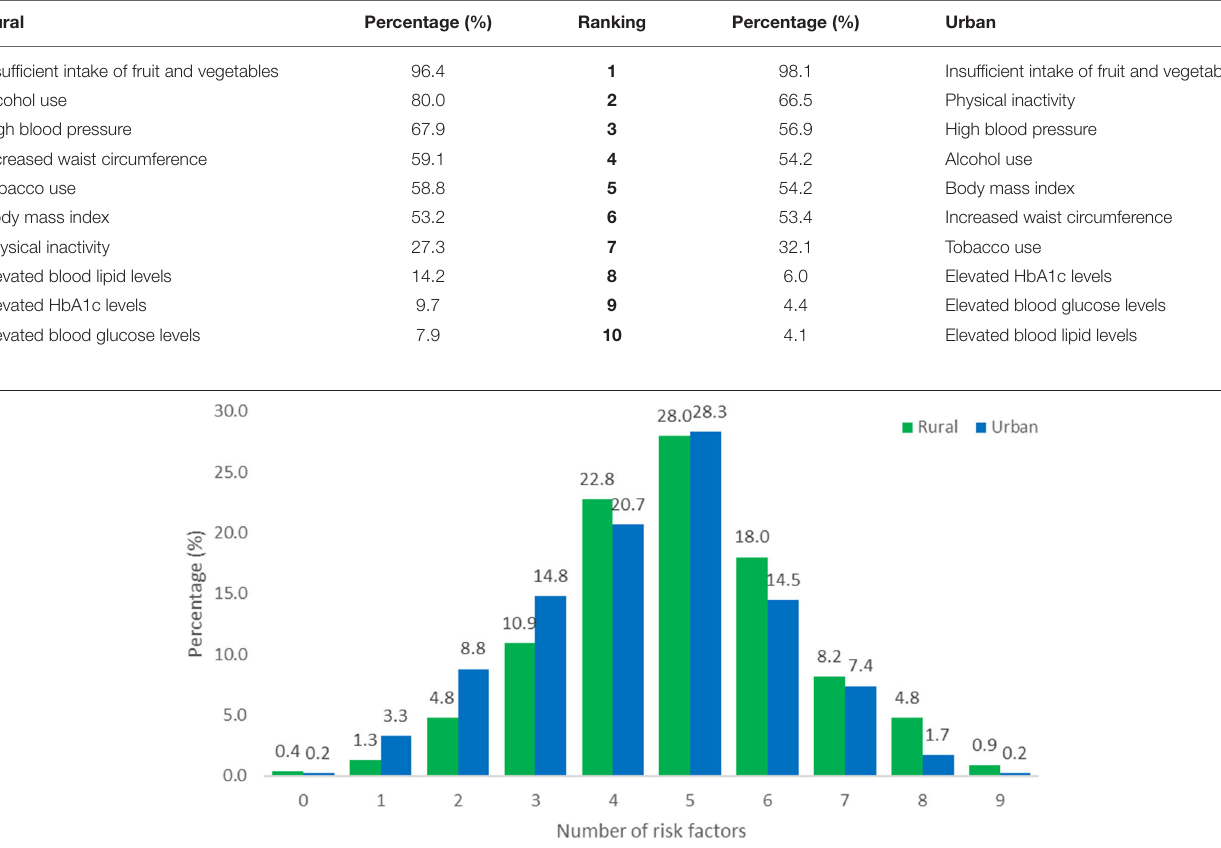
FIGURE 1 | Total number of behavioral and metabolic risk factors for rural ( N = 561) and urban ( N = 420) participants. The data of 14 rural participants and 9 urban participants were